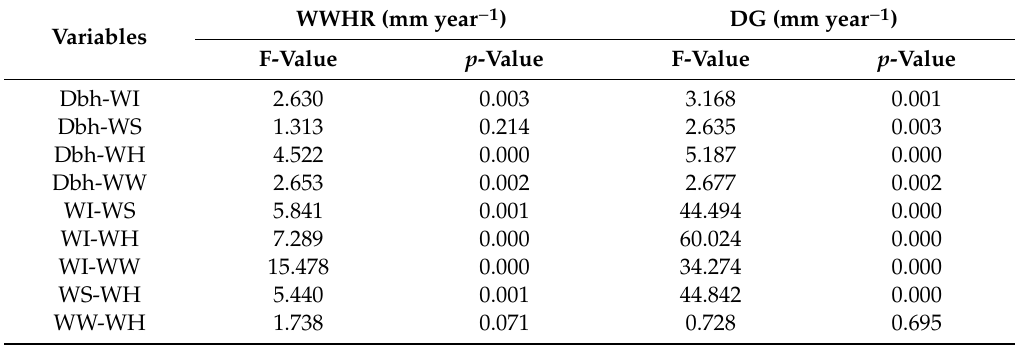
Table 7. ANCOVA results for the interaction of independent variables on wound width healing rate (WWHR) and diameter growth (DG) of loblolly pine stems; dbh: diameter at breast height, 1.30 m; WI: wound intensity; WS: wound size; WH: wound height; WW: wound